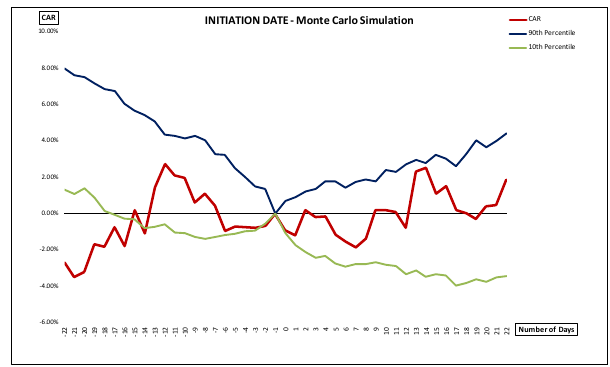
Figure 4: Monte Carlo simulation results of cumulative abnormal returns for the initiation event window The MCS for the conviction date, as plotted in Figure 5,